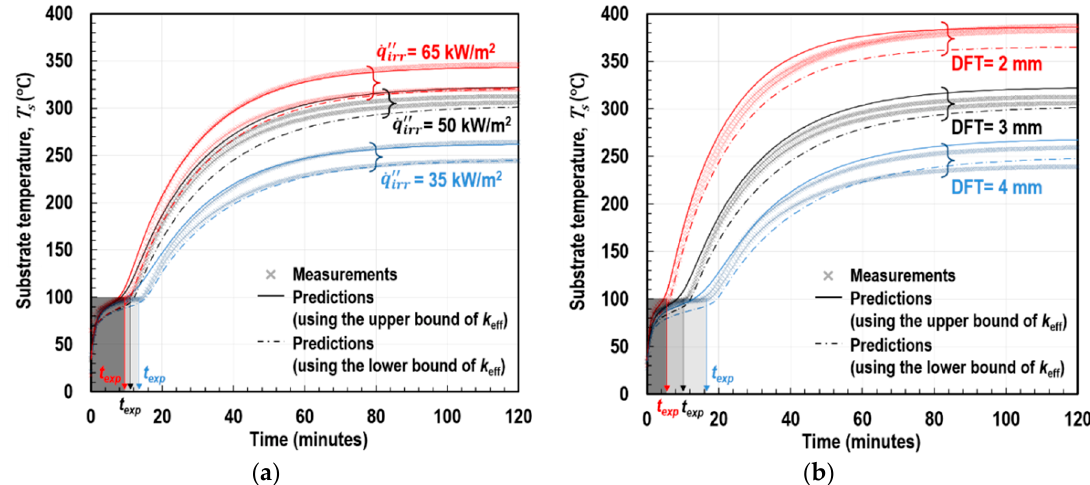
Figure 16. Experimental measurements and numerical predictions of the upper and lower limits of substrate-temperature ( T s ) and thickness expansion ( ℓ z ) over time: ( a ) at DFT = 3 mm and ( b ) at 𝑞(cid:4662) (cid:2919)(cid:2928)(cid:2928)(cid:4593)(cid:4593) = 50 kW/m 2 .